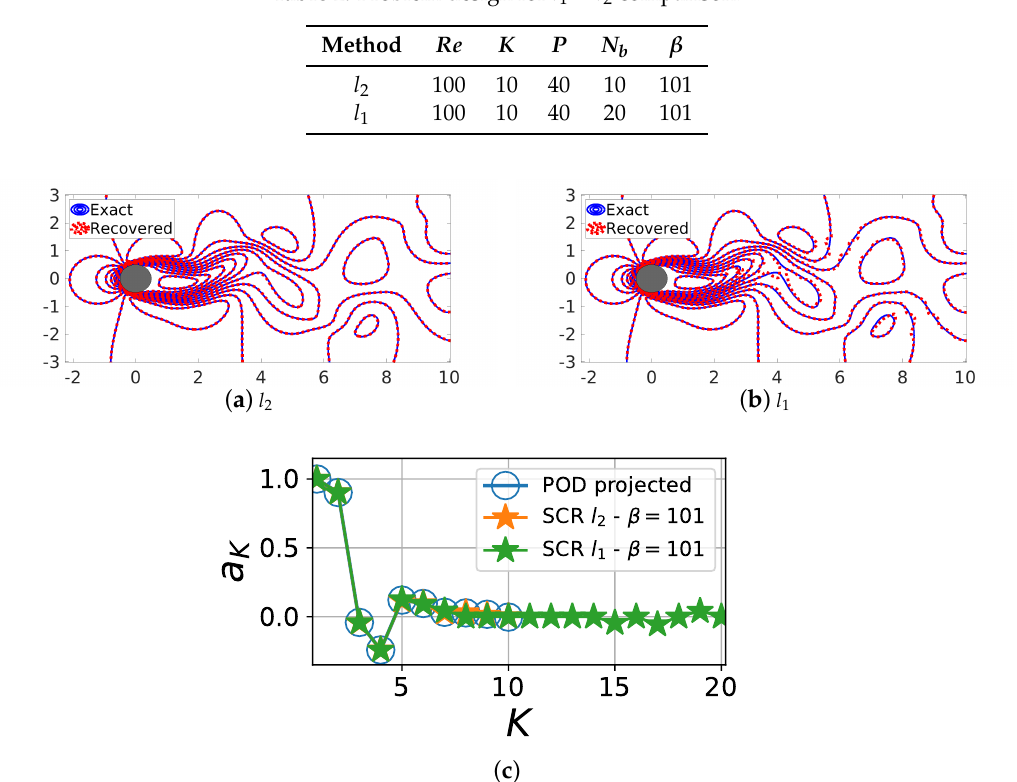
Figure 10. Comparison of the sparse reconstruction using both l 1 and l 2 minimization methods for basis that is ordered in terms of energy content. The reconstructed and actual flowfields at T = 0.2 are compared: ( a ) for l 2 ; and ( b ) for l 1 . The corresponding POD features from both methods are shown in ( c